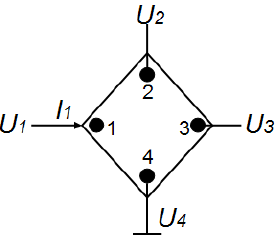
Figure 1. Diagram of measuring Z-matrix for a 90° symmetry Hall plate.